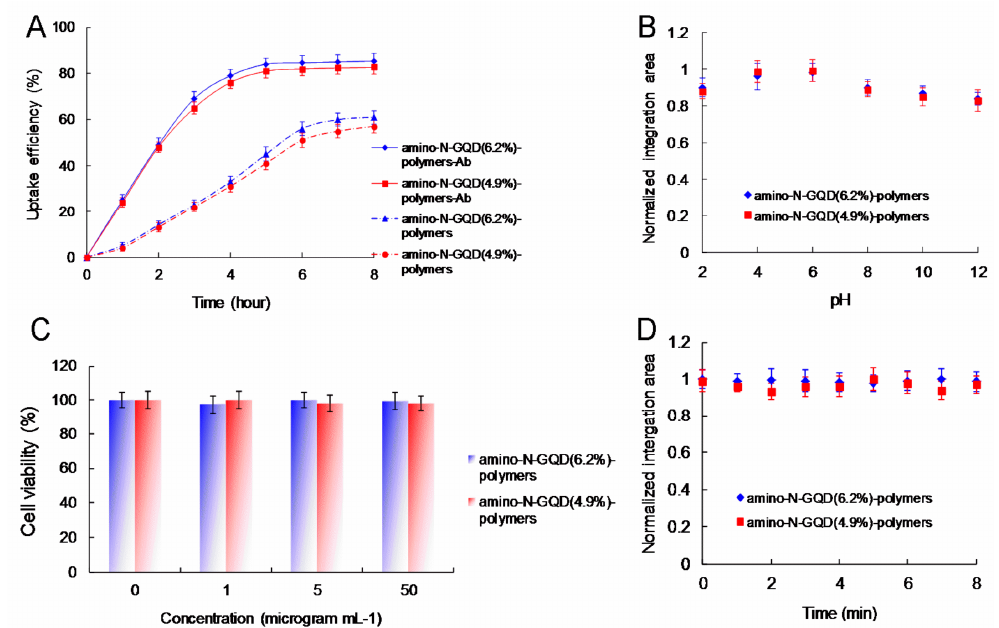
Figure 6. ( A ) Uptake assay results derived for cells treated with nanomaterials for 0–8 h at 37 °C. ( B ) pH-dependent TPL emission of nanomaterials subjected to a TPE power of 2816 nJ pixel − 1 (Ex: 800 nm). The TPL intensity observed for the integrated area was a function of pH (2–12). The intensity